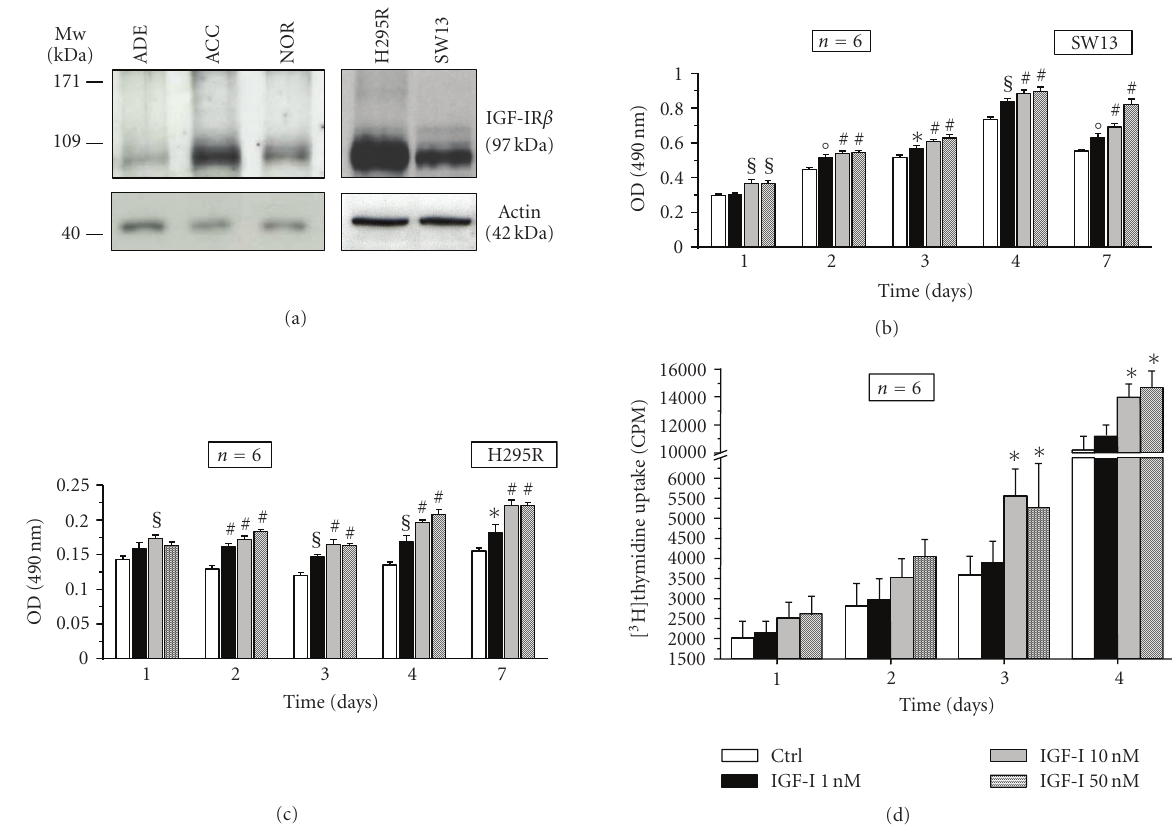
Figure 1: Adrenocortical cancer is responsive to IGFs . (a) Western blot analysis of adrenocortical tissues (adrenocortical carcinoma: ACC; normal adrenal tissue: NOR; adrenocortical adenoma: ADE) and adrenocortical cancer cell lines (SW13 and H295R) reveals a high expression of IGF-IR in cancer tissue and cells and lower levels in normal and adenoma tissues. Western blot for actin was performed for lane protein normalization. Molecular weight (Mw) markers are indicated. The e ff ects of cell incubation with increasing doses of IGF- I (1, 10 and 50nM) for the indicated times on cell proliferation were evaluated by MTS in SW13 (b) and H295R (c) and confirmed in H295R by evaluation of [ 3 H]TdR incorporation in cell DNA content (d). Data represent mean ± SE OD (b), (c) or mean ± SE of [ 3 H]TdR incorporation (counts per minute, cpm) (d). Statistical significance versus respective control: ∗ P < . 05, ◦ P < . 01, § P < . 005, # P < .